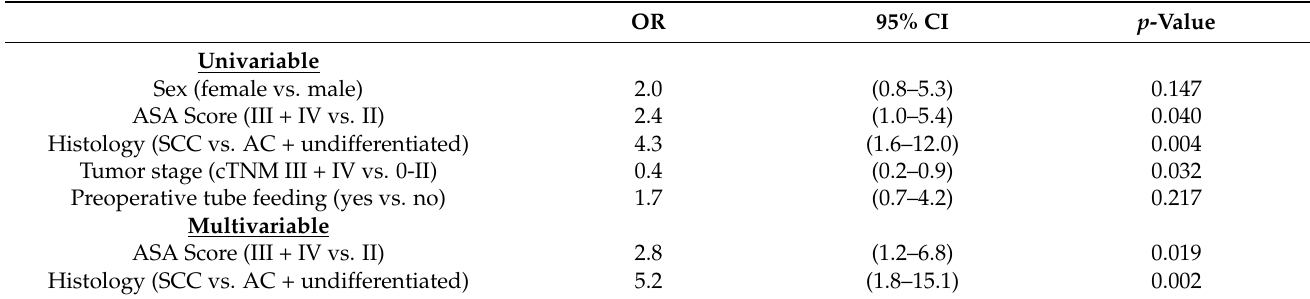
Table 3. Univariable and multivariable regression for nutritional protocol deviation (complication subgroup). OR 95% CI p